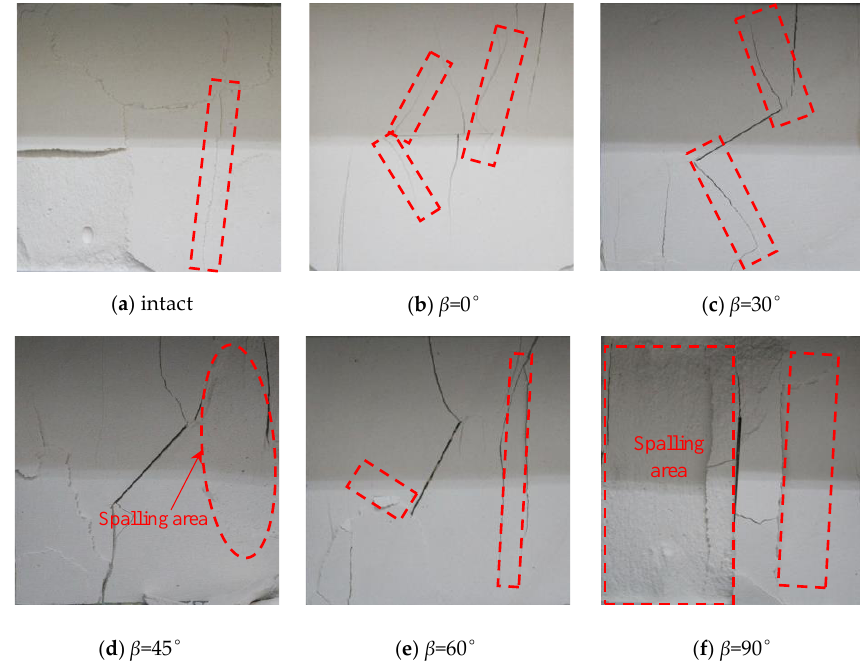
Figure 4. Photographs of specimens at selected key point F in the stress–strain curve.